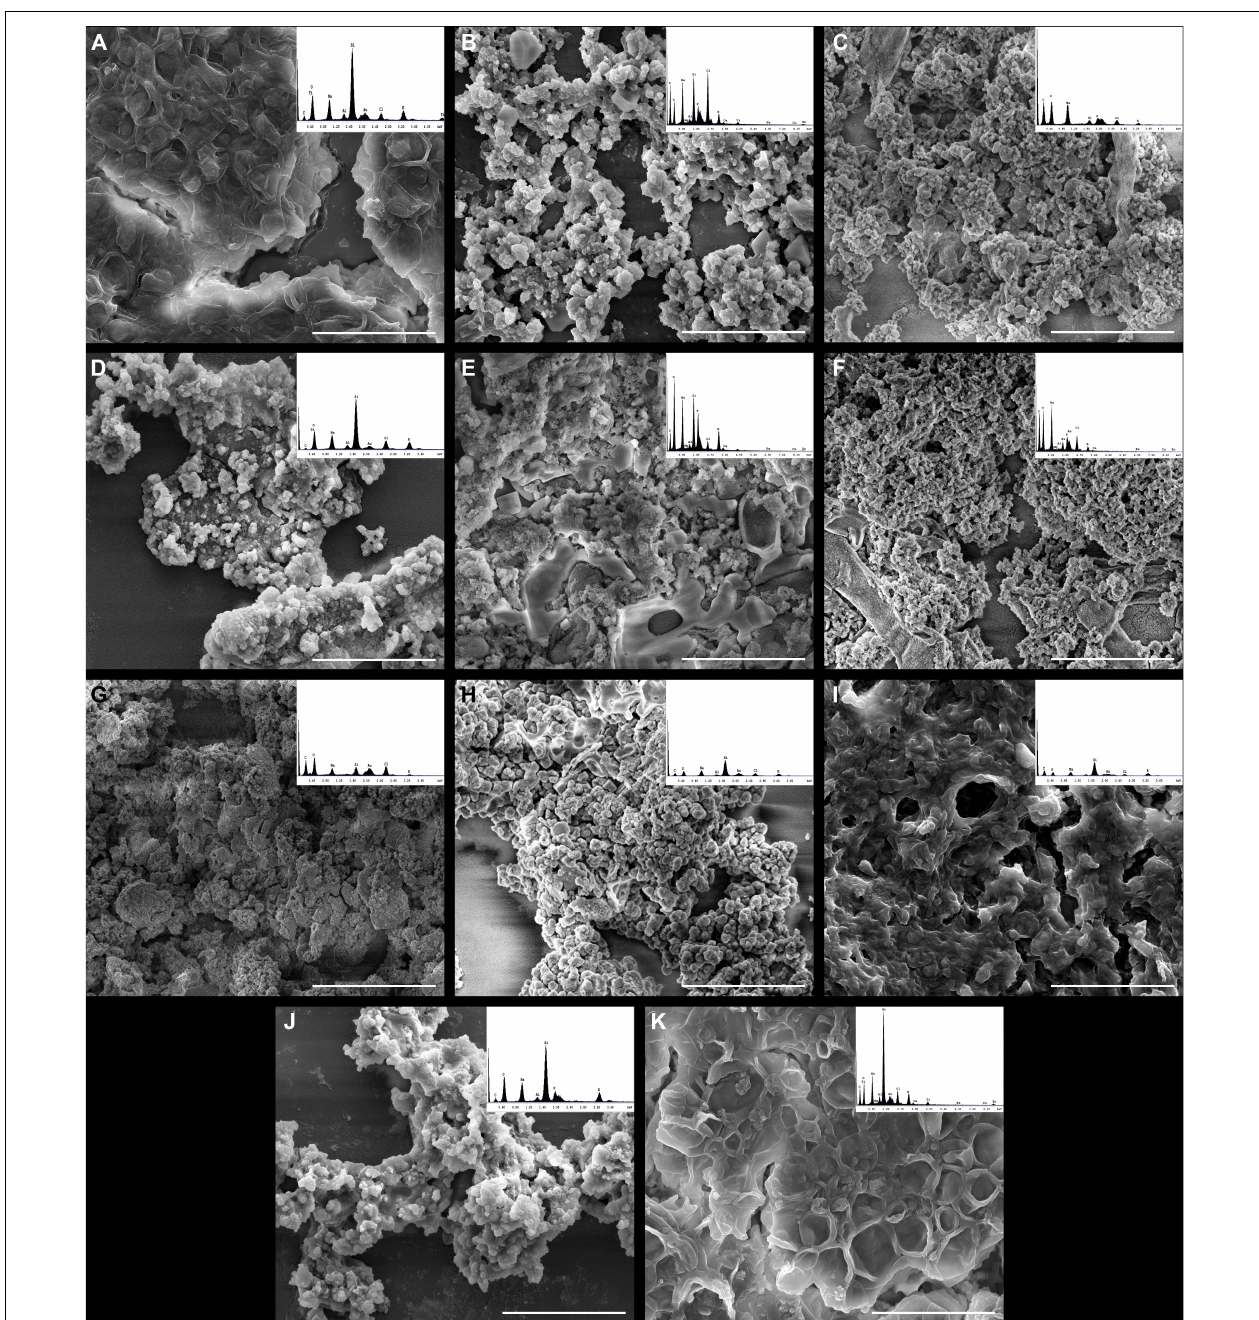
FIGURE 2 | High-resolution scanning electron microscopy and energy-dispersive X-ray spectroscopy (EDS) of melanin produced by clinical strains of different species of the Trichosporonaceae family. (A) Trichosporon asahii (CFP00944), (B) Trichosporon japonicum (CFP00907), (C) Trichosporon faecale (CFP00905), (D) Trichosporon inkin (CFP00904), (E) Trichosporon inkin (ATCC 18020) (CFP00946), (F) Trichosporon inkin (CFP00951), (G) Apiotrichum montevideense (CFP00950), (H) Apiotrichum montevideense (CFP00909), (I) Cutaneotrichosporon debeurmannianum (CFP00913), (J) Cutaneotrichosporon arboriformis (CFP00914), and (K) Cryptococcus neoformans var. grubii H99. The EDS histograms are presented at the upper right corner of each panel and in a larger scale at the Supplementary Figure 1 . Scale bar = 10 µ m.